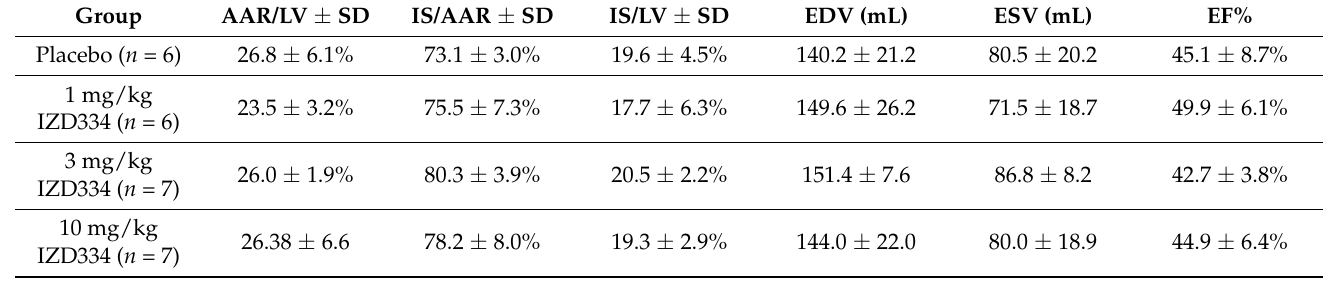
methods (using Shapiro – Wilk test). Hence, a one way-ANOVA was performed. ( A ) The area at risk